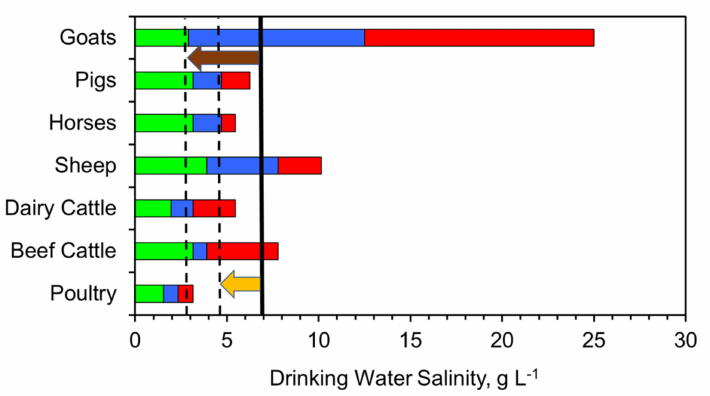
Figure 21. Tolerance of livestock to salinity. Green = safe; blue = suitable; green = poor. Black line = average saline water salinity of 6.9 g L − 1 ; Dashed black line = average partially desalinated water salinity with 30% desalination, and 60% desalination; Orange arrow indicates the salin- ity removed by 30% partial desalination. Brown arrow indicates the salinity removed by 60% partial